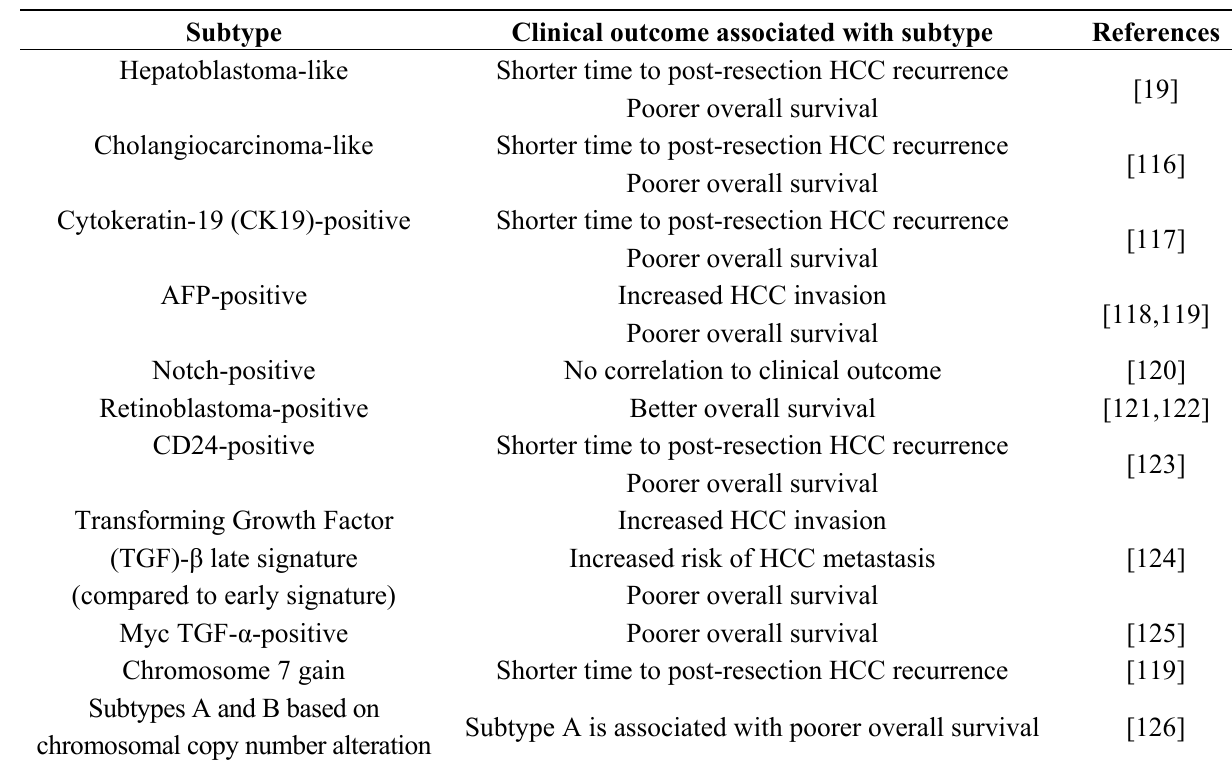
Table 1. Previously reported HCC subtypes and their associated clinical